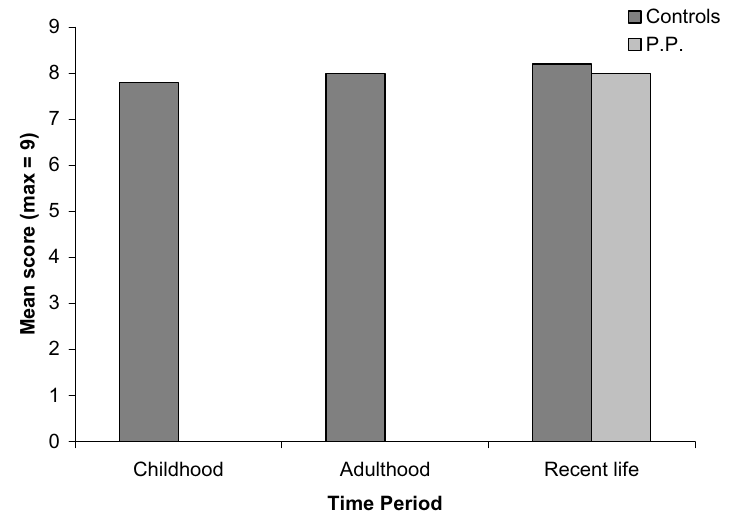
Fig. 1. P.P.’s performance on the Episodic Autobiographical Memory section of the Kopelman Autobiographical Memory Interview (AMI, Kopelman [24]). He obtained pathological concerning performance ( = 0) all periods preceding the onset of his amnesia. Concerning more recent life events, he obtained normal scores and could recall detailed personal events experienced between August 2004 (the onset of his amnesia) and March 2005 (date of